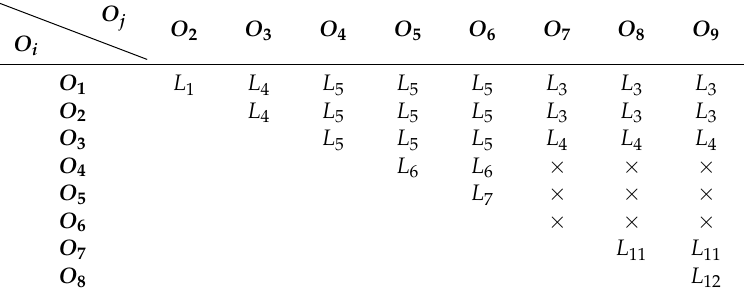
Table 5. Results of fault line selection by using any two observers.